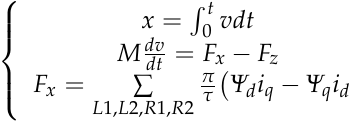
Figure 8. Part C of the motor model.